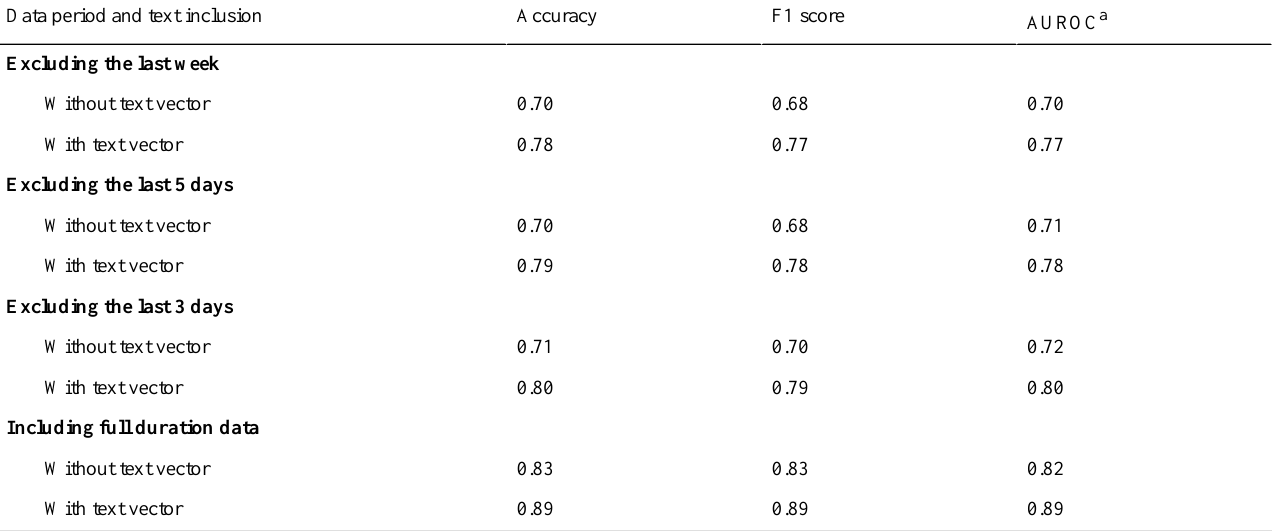
Table 3. Performance